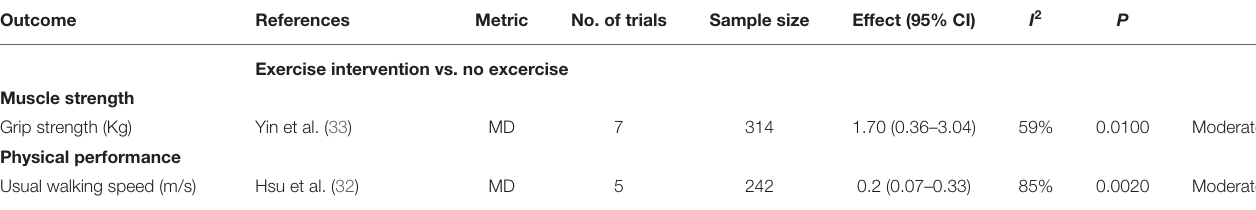
TABLE 3 | Comparison of overlapping results between meta-analyses of RCTs in people with obesity